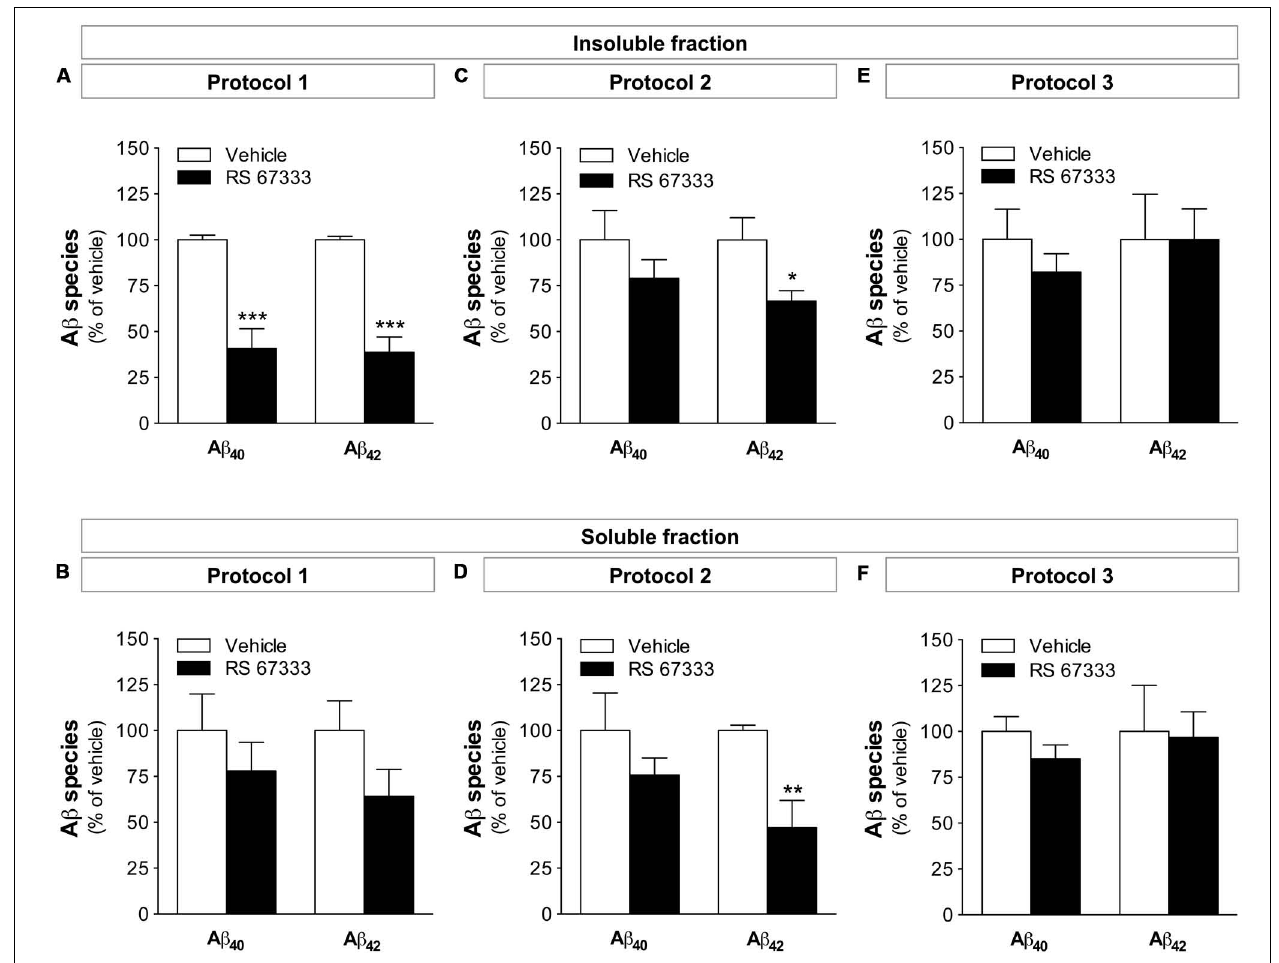
FIGURE 3 | Early chronic administration of RS 67333 reducesA β 40 and A β 42 levels in 5XFAD mice. 5XFAD female (3 or 4 months at termination) mice were treated chronically with 1 mg/kg RS 67333 twice a week according to protocol 1 (A,B) , protocol 2 (C,D) or protocol 3 (E,F) .Total A β 40 and A β 42 species were quantified in the insoluble (A,C,E) and soluble (B,D,F) brain fractions. Data are the mean ± SEM. ∗ p < 0.05, ∗∗ p < 0.01, ∗∗∗ p < 0.001